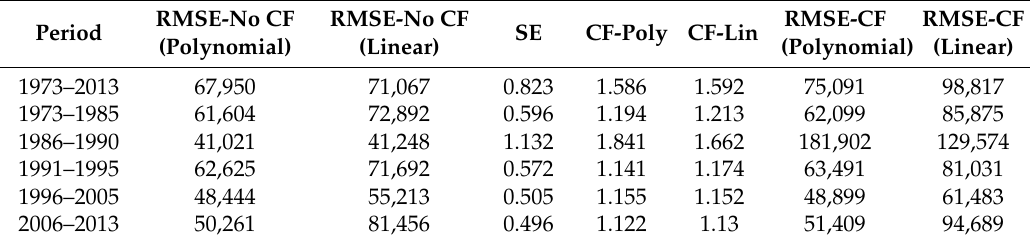
Table 2. Root mean square errors (RMSEs) of DSL s predicted through discharge-sand load rating curves for each period in Table 1. Here, SE is the standard error and CF-Poly is the Duan correction factor used in polynomial rating curves, while CF-Lin is the Duan correction factor used in linear rating curves. “No CF” represents DSL s calculated without applying correction factors during their retransformation from predicted ln DSL s while “CF” represents DSL s calculated by applying the correction factors during the retransformation